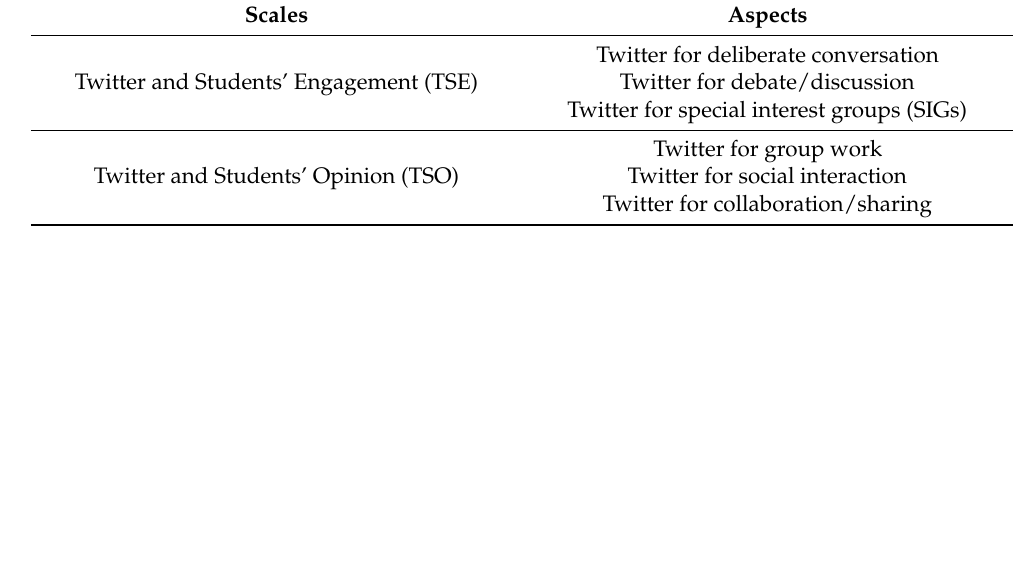
Table 2. Scales and aspects of this study. Scales Aspects Twitter and Students’ Engagement